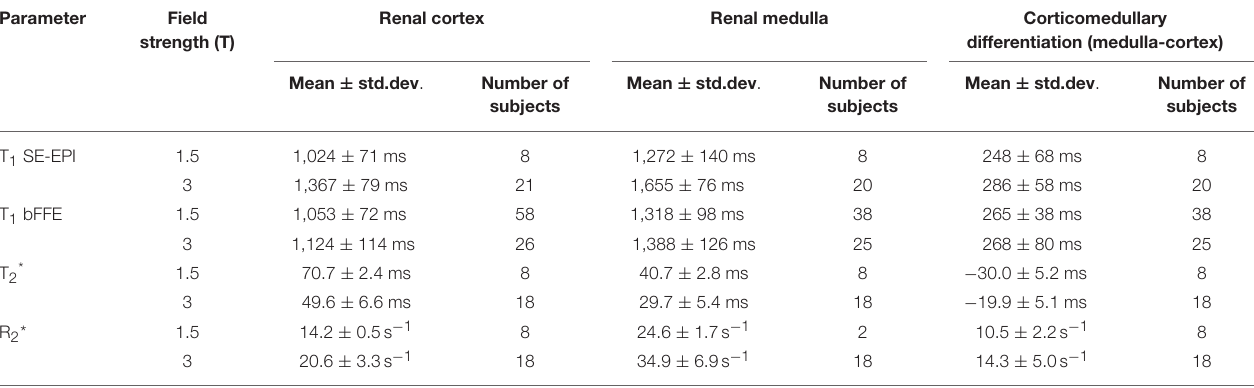
TABLE 3 | Intra subject repeatability for the multiparametric MRI measures in healthy participants. Parameter Repeatability measures Single renal artery flow Single renal vein flow